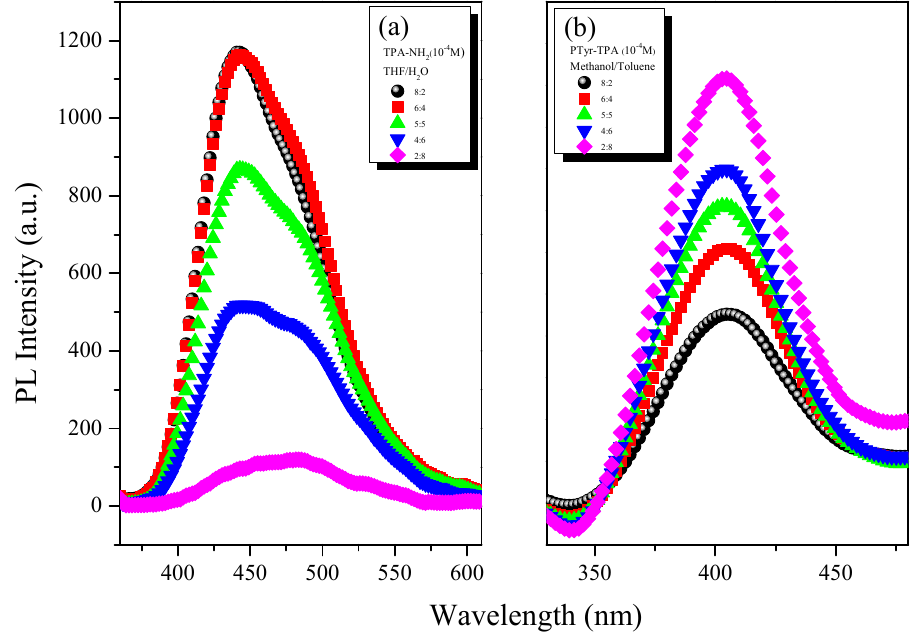
Figure 7. PL spectra (excitation wavelength: 330 nm) of: ( a ) TPA-NH 2 in THF/H 2 O; and ( b ) PTyr-TPA in CH 3 OH/toluene at a concentration of 10 − 4 M.